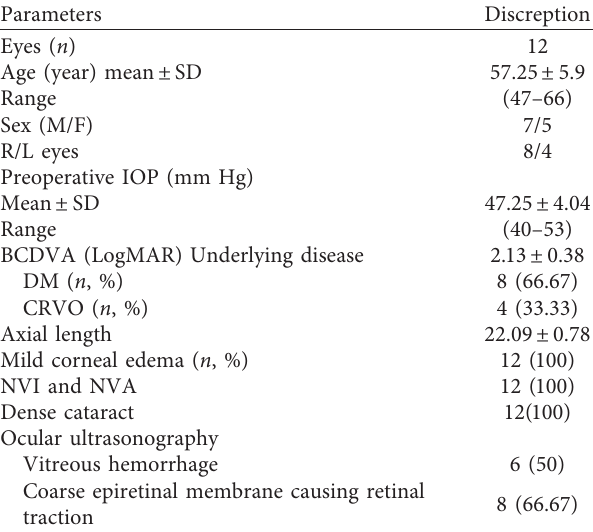
Table 1: Patients’ demographic